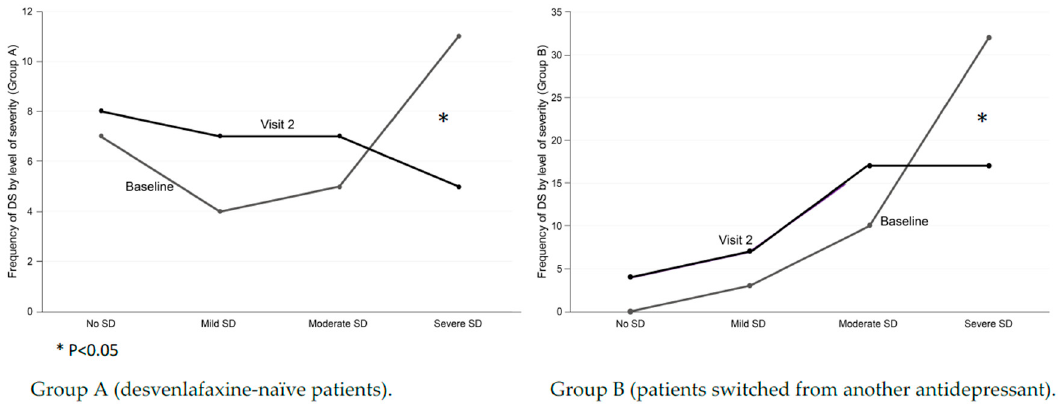
Figure 2. Differences in sexual level of severity from baseline at three months in patients treated with desvenlafaxine.